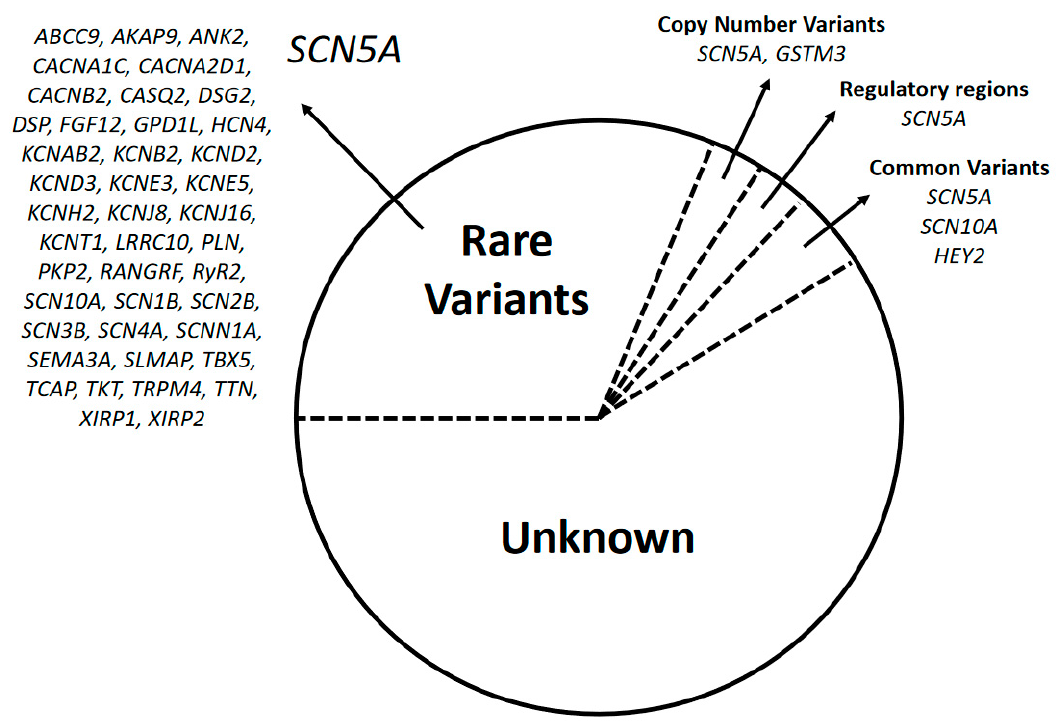
Figure 1. Genetics of Brugada syndrome (BrS). After a comprehensive genetic analysis, almost 60% of patients remain without a genetic diagnosis. No more than 35% of cases are due to rare variants; of them, almost 30% are located in the SCN5A gene. Other alterations such as copy number variants, variants in regulatory regions and common variants are responsible altogether for less than 10% of BrS cases.